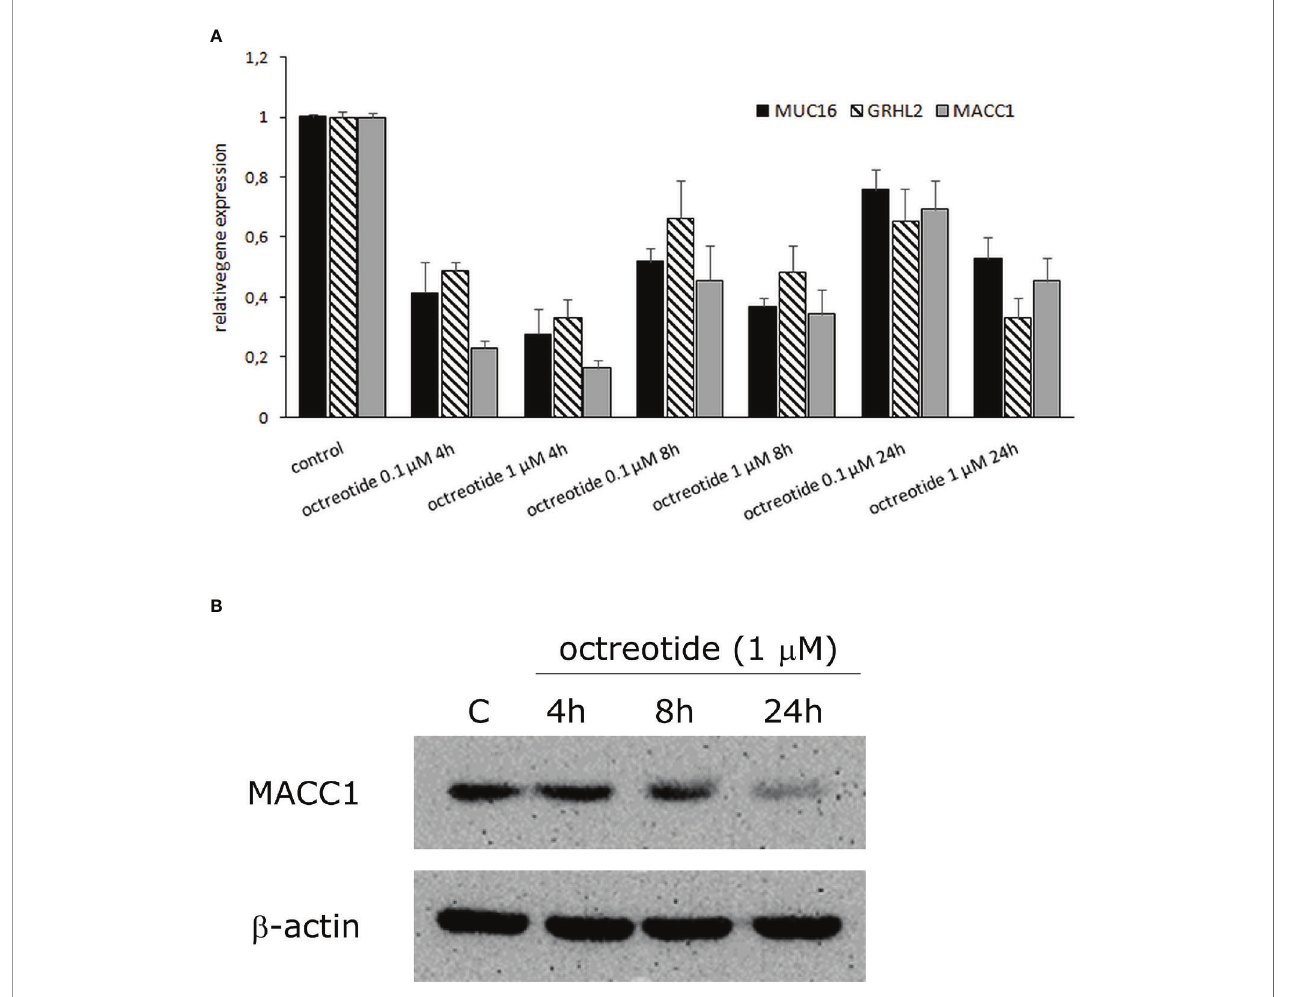
FIGURE 4 | Effect of octreotide on MUC16 , GRHL2 , and MACC1 gene expression in GH3 cells. (A) Cells were treated with 0.1 µM and 1 µM octreotide for 4, 8, and 24 h. Gene expression was analyzed by real-time PCR and expressed relative to value from untreated control cells, which was de fi ned as 1. Data were normalized to GUSB and values were calculated using a comparative (2- D Ct) method. Results are mean ± SD from two independent experiments. (B) Western blot analysis of MACC1 protein expression in octreotide treated GH3 cells. b -actin was used as a loading control. The experiments were performed twice with similar